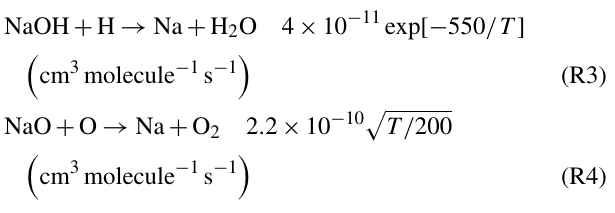
the downward transport of minor species. In addition,